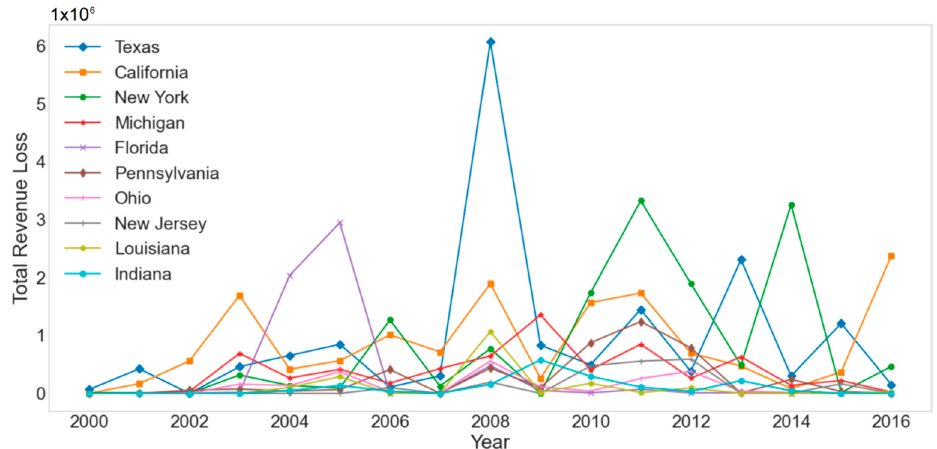
Figure 13. Total revenue loss for top 10 individual states during 2000–2016 due to power outages.